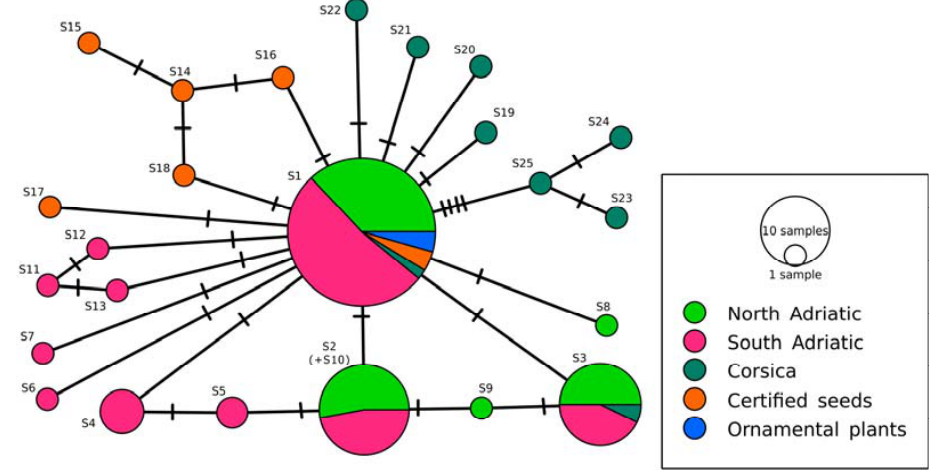
Figure 2. HII TCS network with ITS1-5.8S-ITS2 sequence variants. Sequences with labels from S1 to